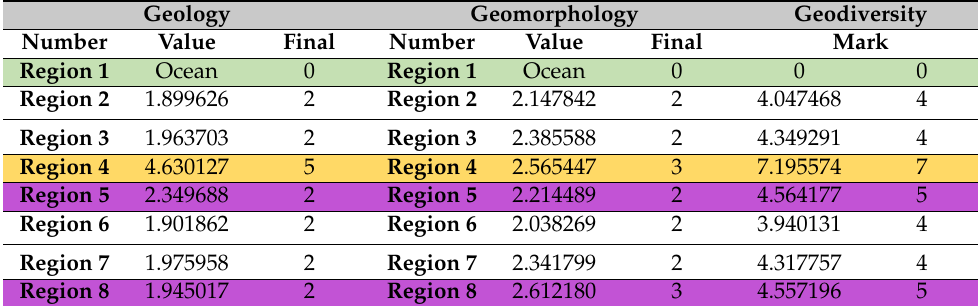
Table 5. The results of assessment of geodiversity of Port Jackson, Fletcher Bay, and Port Charles territory. Eight regions were assessed to obtain the results. The table shows the results for Geological and Geomorphological assessment. Columns for Geodiversity are sum of geology and geomor- phology values. Numbers show regions 1–8 presented in article above (Figures 3–7). Value is the column showing the formulaic results after calculation. Final is the same value but presented as whole numbers (suggested by Excel Office). Colour codes correspond to the same geodiversity class calculated.